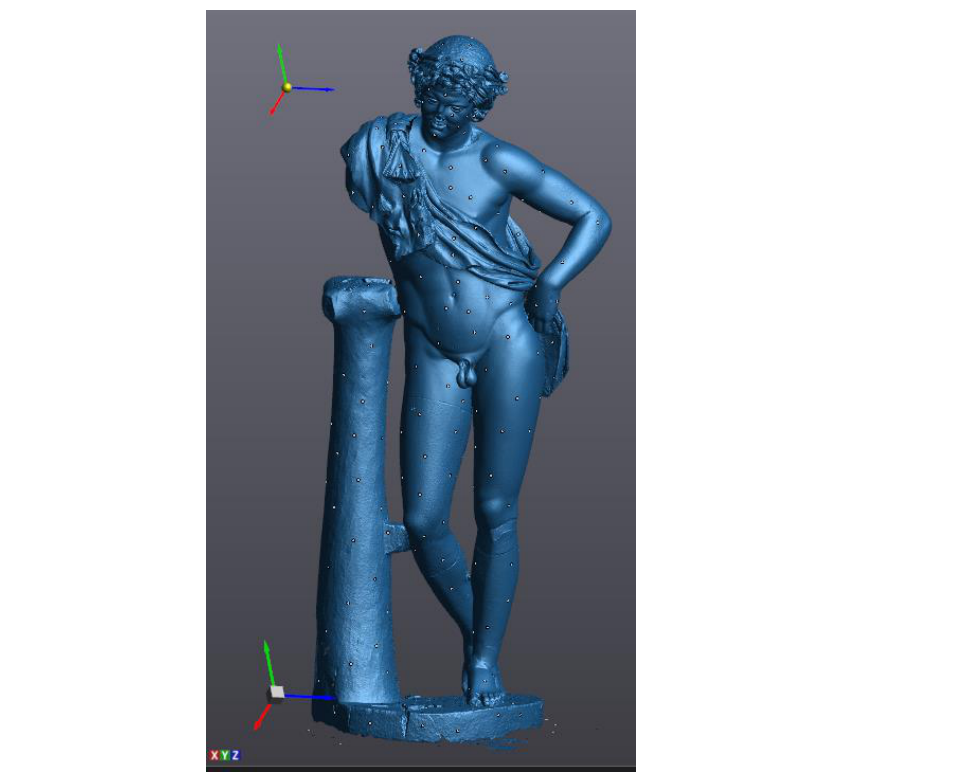
Figure 16. Result of scanning process in VXelements.